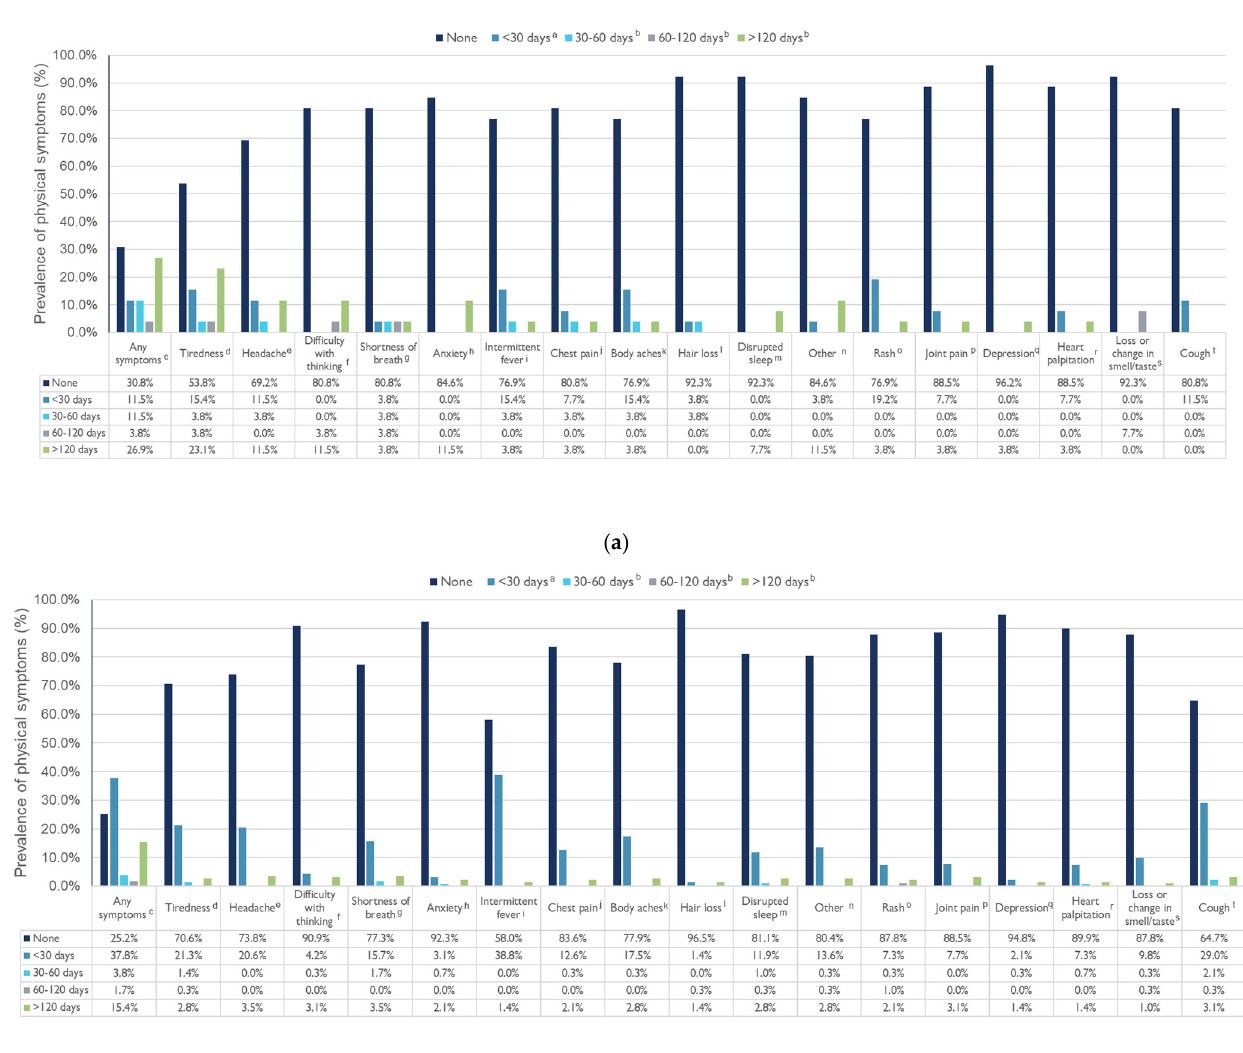
Figure 2. Prevalence and duration of physical symptoms among MIS-C ( a ) and non-MIS-C children ( b ). a Acute symptoms ; b Chronic long symptoms; c MIS-C: N missing = 4; non-MIS-C: N missing = 46; d